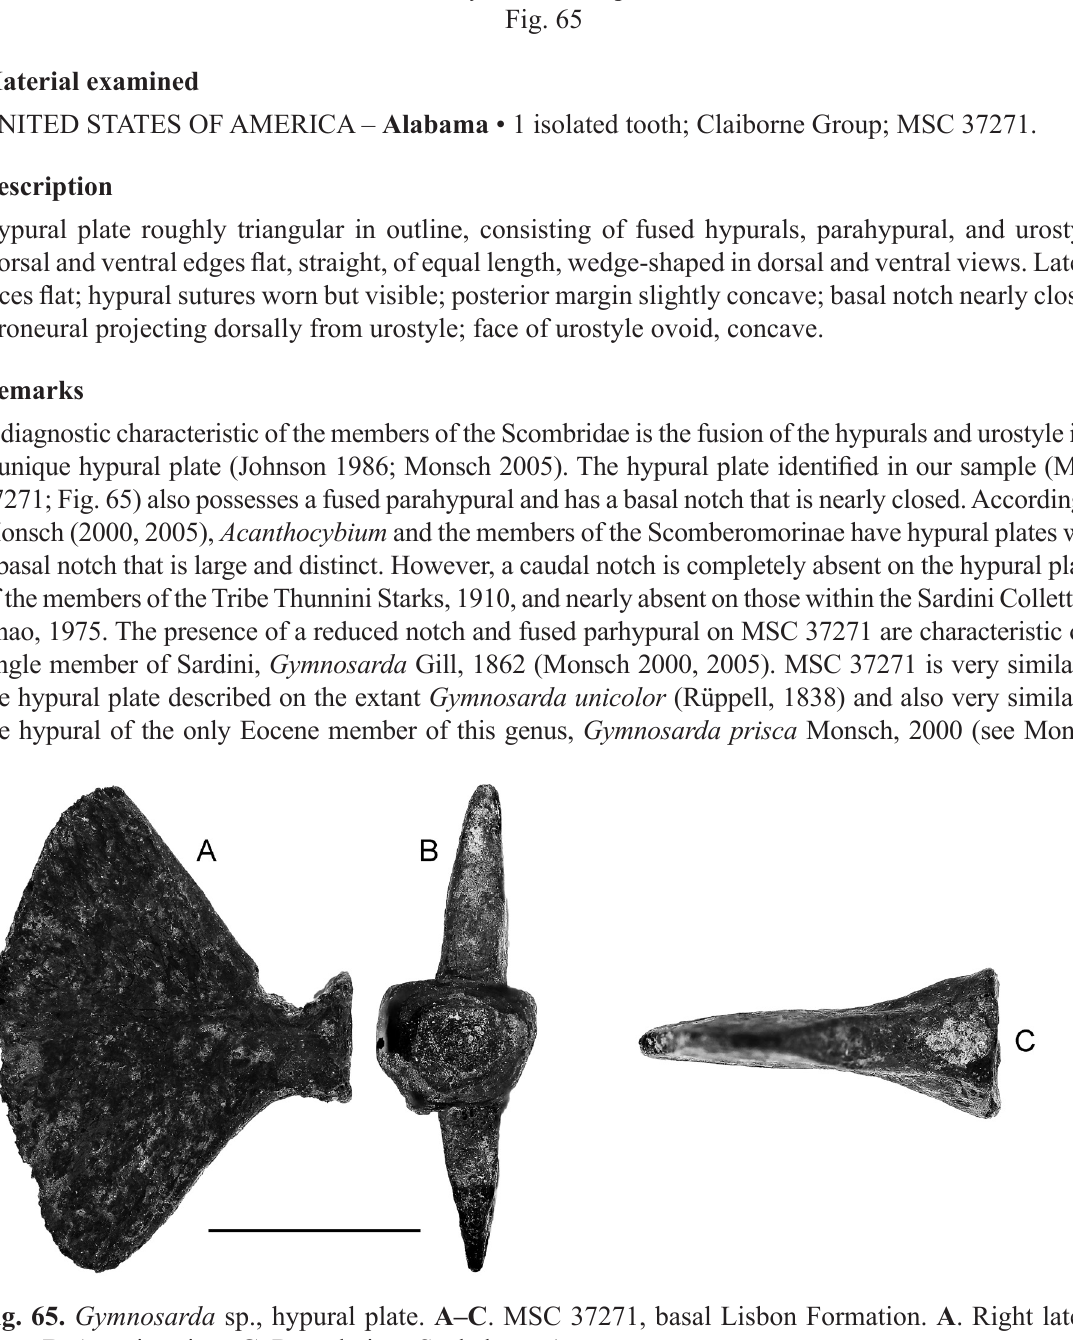
Fig. 65. Gymnosarda sp., hypural plate. A–C . MSC 37271, basal Lisbon Formation. A . Right lateral view. B . Anterior view. C . Dorsal view. Scale bar =